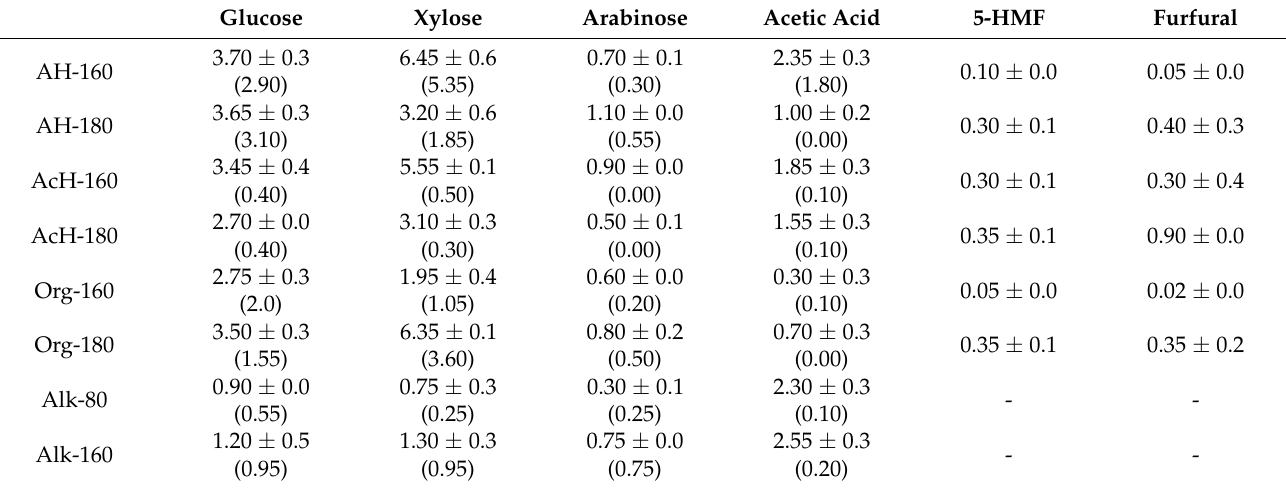
Table 4. Sugars and degradation compounds (g/L) of the liquid fractions from the different pretreatments of Ademuz elm